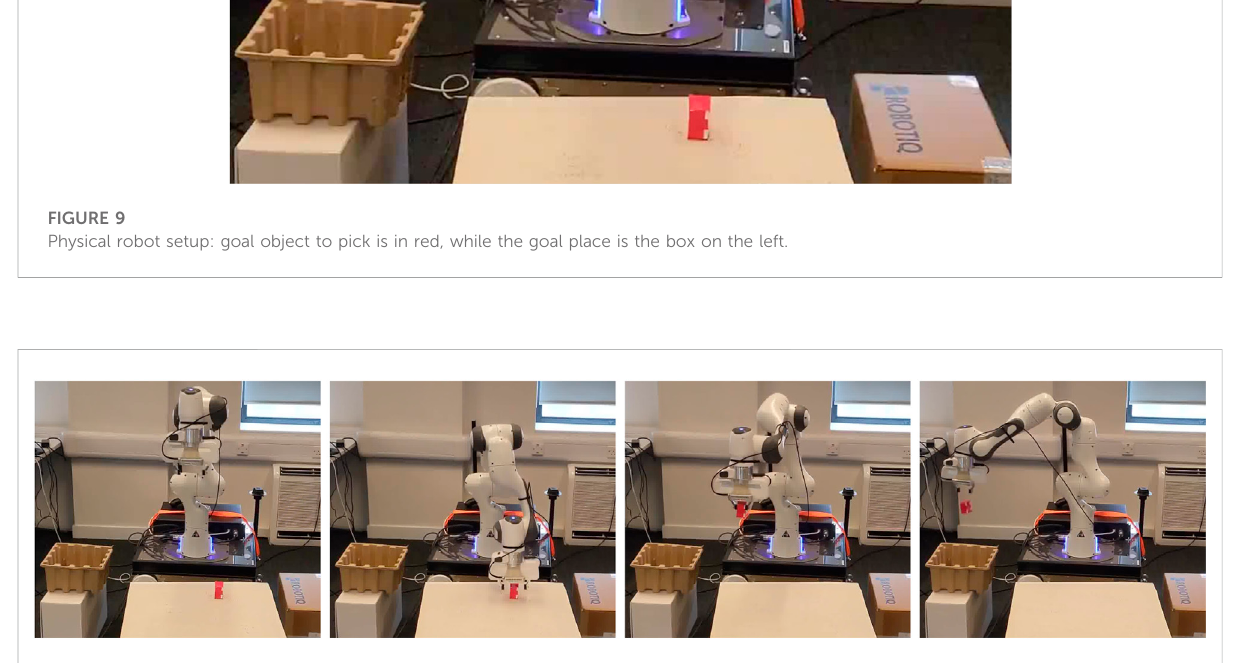
FIGURE 10 BPL successful implementation on the real setup (times advances from left to right). The policy learned in simulation is able to achieve 67% success rate on the physical setup despite the reality gap and mismatches on the low-level controller.